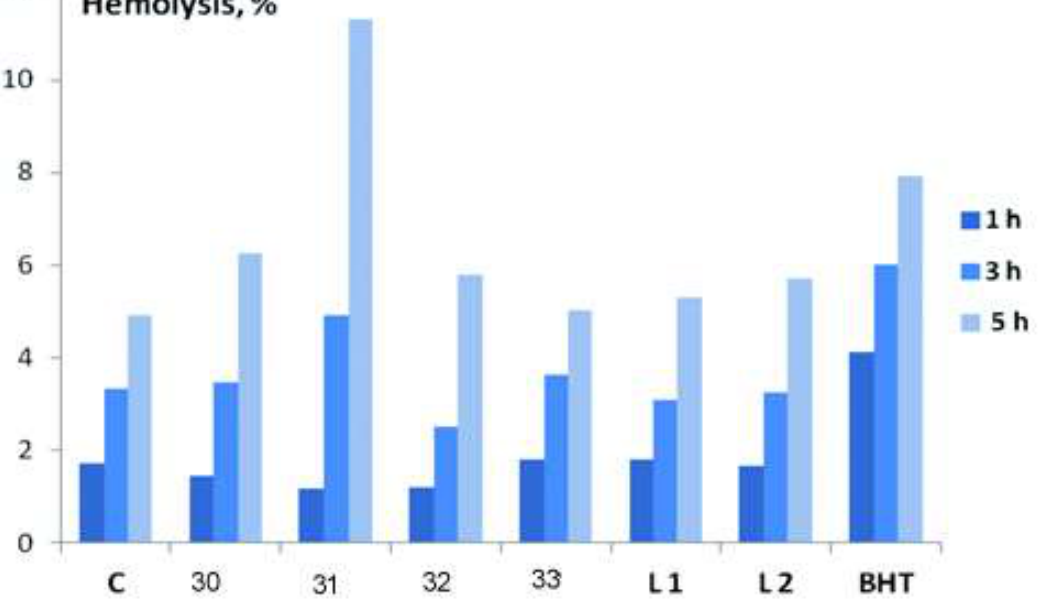
Figure 6. Hemolytic activity of the test compounds (Cu chelates 30–33, ligands L1 (34) & L2 (35)) at a concentration of 10 µ M after 1, 3, and 5 h of incubation. C—control without test compounds. BHT— standard antioxidant 2,6-di-tert-butyl-4-methylphenol. Reproduced from the permission of ref. [144]. Devi et al. (2022) prepared multiple Cu(II), Co(II), Zn(II), and Ni(II) chelates through four Schiff organic ligands (BHAP) (36), BHACM (37), BHACN (48), and BHIMP (39) gained through the reaction of 4-(benzyloxy)-2-hydroxybenzaldehyde with several aminophenols and were considered through many spectral techniques as represented in Scheme S3. The tested substances (from 36 to 55) were estimated for their antioxidant performance in vitro then found that the prepared M 2+ chelates were very powerful, dis- playing proficiency for decolorizing the purple solution of DPPH related to free ligands. Cu-chelates had the highest potency, with IC 50 data as 2.98 toward 3.89 μM range. As represented in Table 4, the MOD of organic ligand BHACM (37) and its copper-chelate with enzyme; C. Albicans sterol 14-alpha demethylase recommended the hydrophobic binding. Moreover, in silico test strained which meant the tested materials could be uti- lized as orally active drugs [145]. Table 4. In vitro DPPH scavenging capacities (IC 50 , μM) of reference drugs, ligands, and their metal (II) chelates (36–55) [145]. C. No